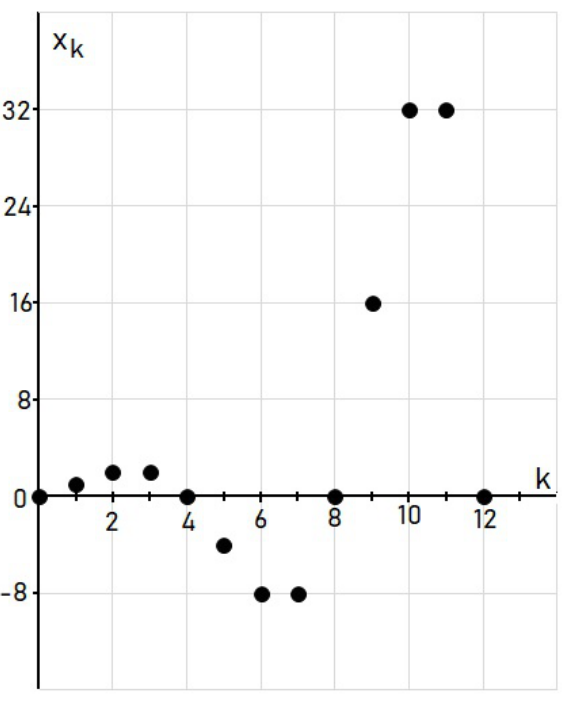
Figure 2: The diagram of the function (17) for { x